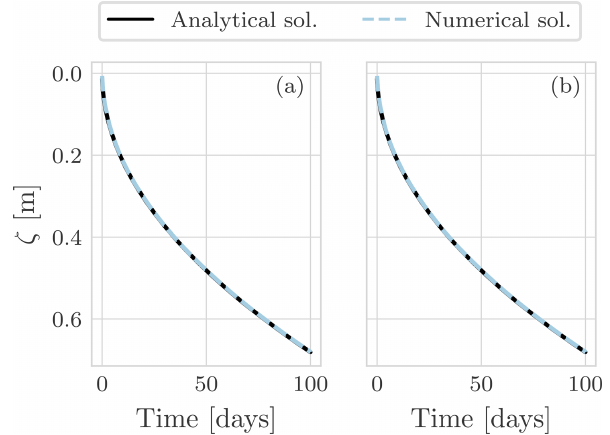
Figure 3. Propagation of the freezing front compared between the Neumann analytical and the numerical solution with the NCZ al- gorithm. Two space discretizations are used: (a) (cid:49)z = 0 . 005m and (b) (cid:49)z = 0 . 001m. The integration time step is (cid:49)t = 3600s.